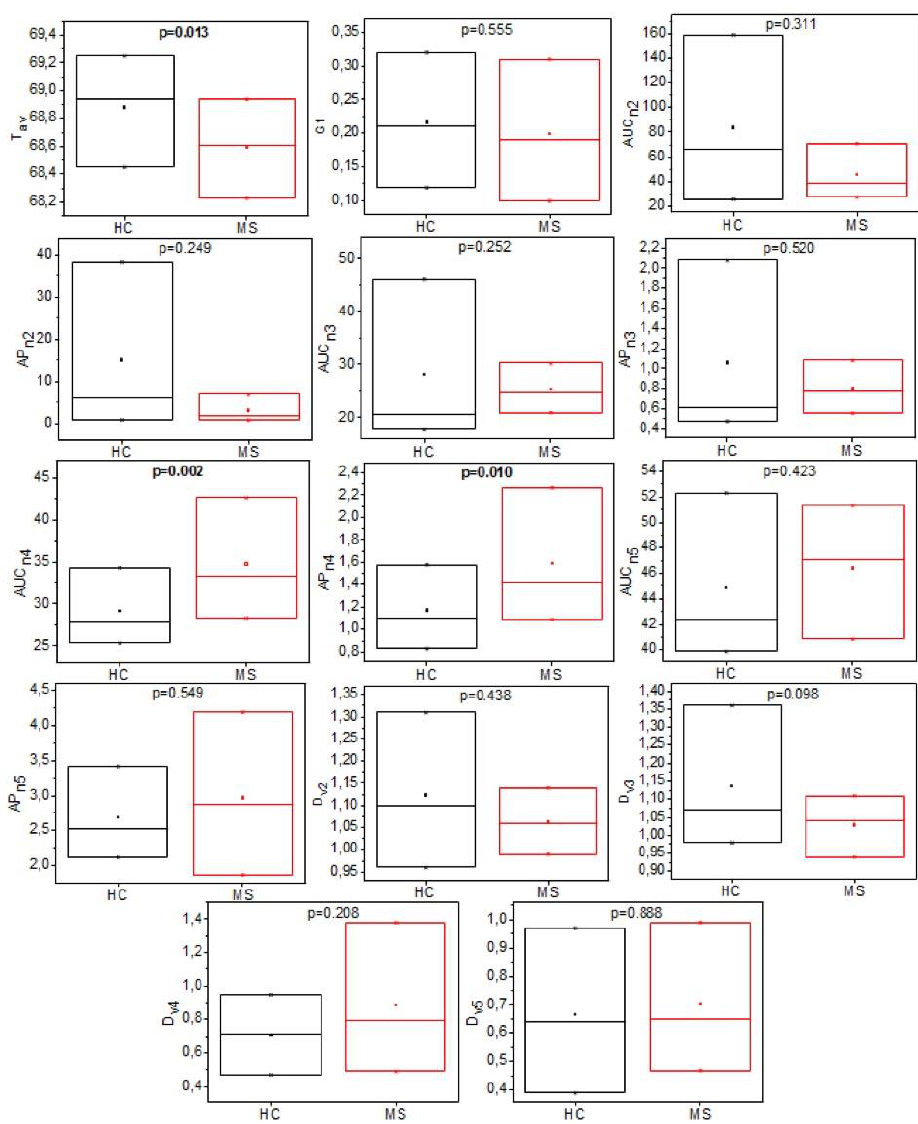
Figure 3. Box-plot for each individual parameter, derived from the deconvolution analysis of the thermograms, illustrating the distribution of their values in each